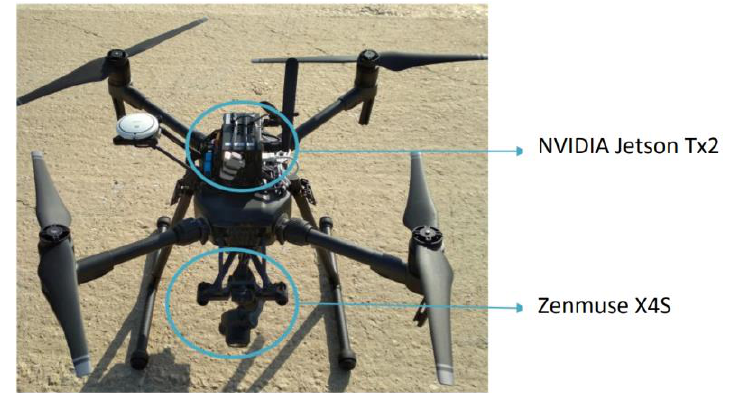
Figure 23. Drone and onboard computer